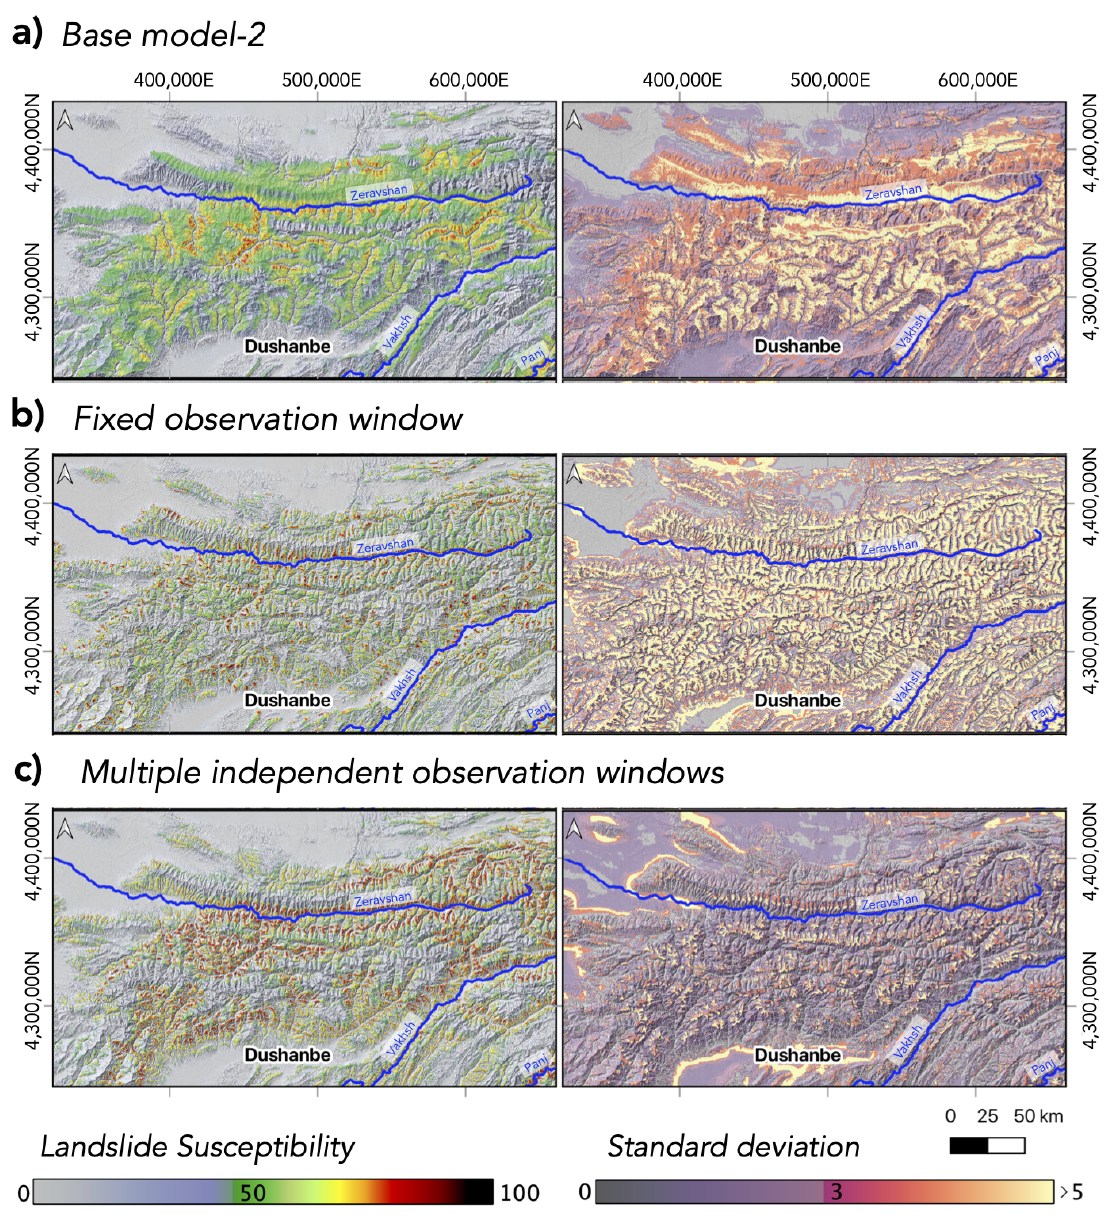
Figure 7. Mean landslide susceptibility and reliability maps from the best performing models classified by the sensitivity analysis. ( a ) Base model-2 that includes slope, aspect, geology, distance to fault, NDVI, precipitation, isothermality, TWI, distance from channel and elevation above channel as source of information. ( b ) Model that includes the window-based morphometric indices calculated with an observation window fixed at 5000m. ( c ) Model that includes the window-based morphometric indices that are calculated with multiple and independent observation windows. Left: mean landslide susceptibility map from 50 iterations of the same model. Right: standard deviation to the mean landslide susceptibility from 50 iterations of the same